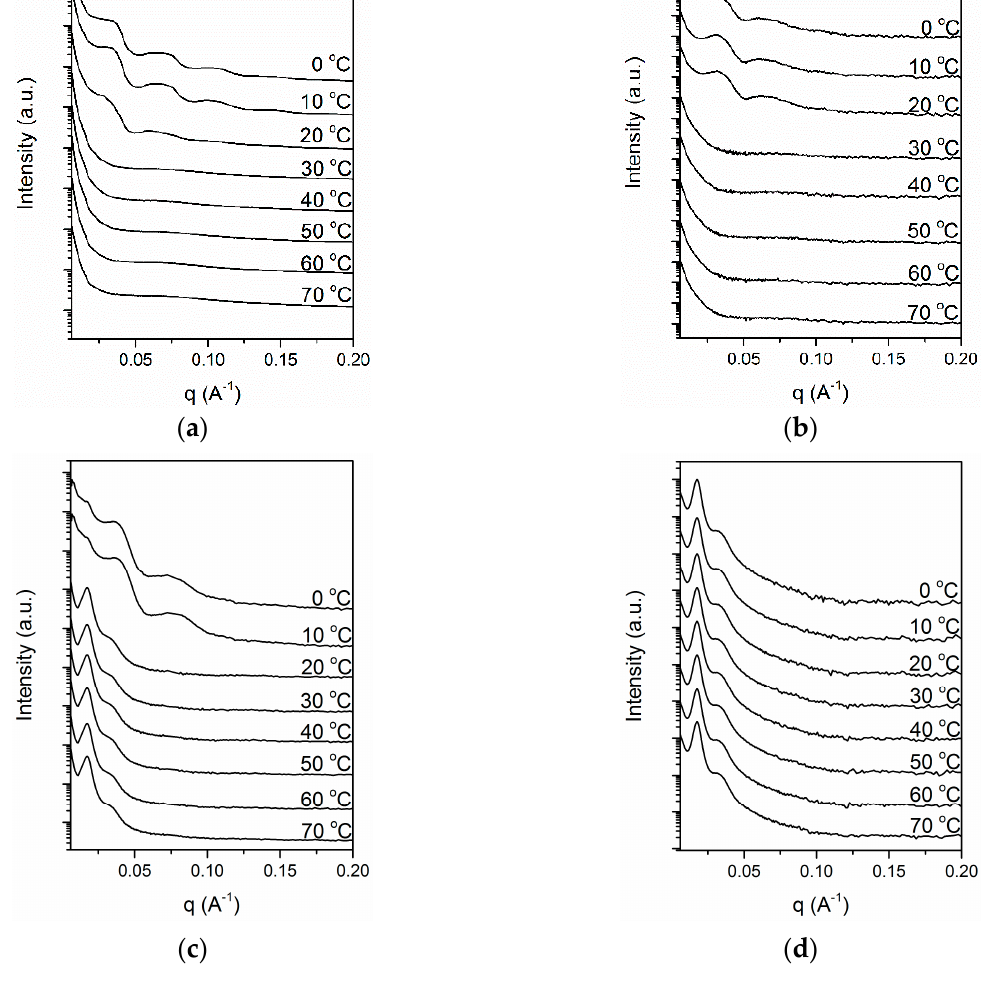
Figure 9. Time-resolved small-angle X-ray scattering (SAXS) patterns of PEG and its complexes with Azo during nonisothermal crystallization at a cooling rate of 5 ◦ C / min. ( a ) PEG, ( b ) 10:90 Azo / PEG, Azo during nonisothermal crystallization at a cooling rate of 5 ° C/min. ( a ) PEG, ( b ) 10:90 Azo/PEG, ( c ) 25:75 Azo / PEG, and ( d ) 50:50 Azo / PEG. The complex compositions are designated in wt ( c ) 25:75 Azo/PEG, and ( d ) 50:50 Azo/PEG. The complex compositions are designated in wt %.